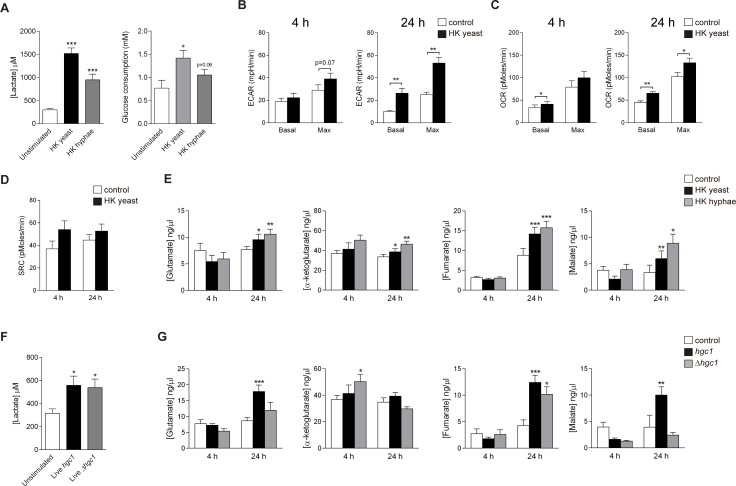
Candida stimulation induced glycolysis in human monocytes.(A) Lactate production and glucose consumption by monocytes after overnight stimulation with heat-killed C. albicans yeast or heat-killed C. albicans hyphae (mean ± SEM, n = 12 for lactate, n = 6 for glucose; pooled from 2–4 independent experiments). *p<0.05, ***p<0.001 Wilcoxon signed-rank test. (B-D) Basal and maximum extracellular acidification rates (ECAR; B), basal and maximum oxygen consumption rates (OCR; C) or spare respiratory capacity (SRC; D) of monocytes were determined by Seahorse analysis at 4 and 24 h after stimulation with medium or heat-killed C. albicans yeast (mean ± SEM, n = 6–8; pooled from 2 independent experiments). *p<0.05, **p<0.01 Wilcoxon signed-rank test. (E) Intracellular metabolite levels of monocytes 4 and 24 h after heat-killed C. albicans yeast or heat-killed C. albicans hyphae stimulation (mean ± SEM, n = 6–8; pooled from 2 independent experiments). *p<0.05, **p<0.01 Wilcoxon signed-rank test. (F) Lactate production by monocytes after overnight stimulation with live hgc1 or Δhgc1 C. albicans. (mean ± SEM, n = 6; pooled from 2 independent experiments). *p<0.05, Wilcoxon signed-rank test. (G) Intracellular metabolite levels of monocytes 4 and 24 h after hgc1 or Δhgc1 live C. albicans stimulation (mean ± SEM, n = 6; pooled from 2 independent experiments). *p<0.05, **p<0.01 Wilcoxon signed-rank test.